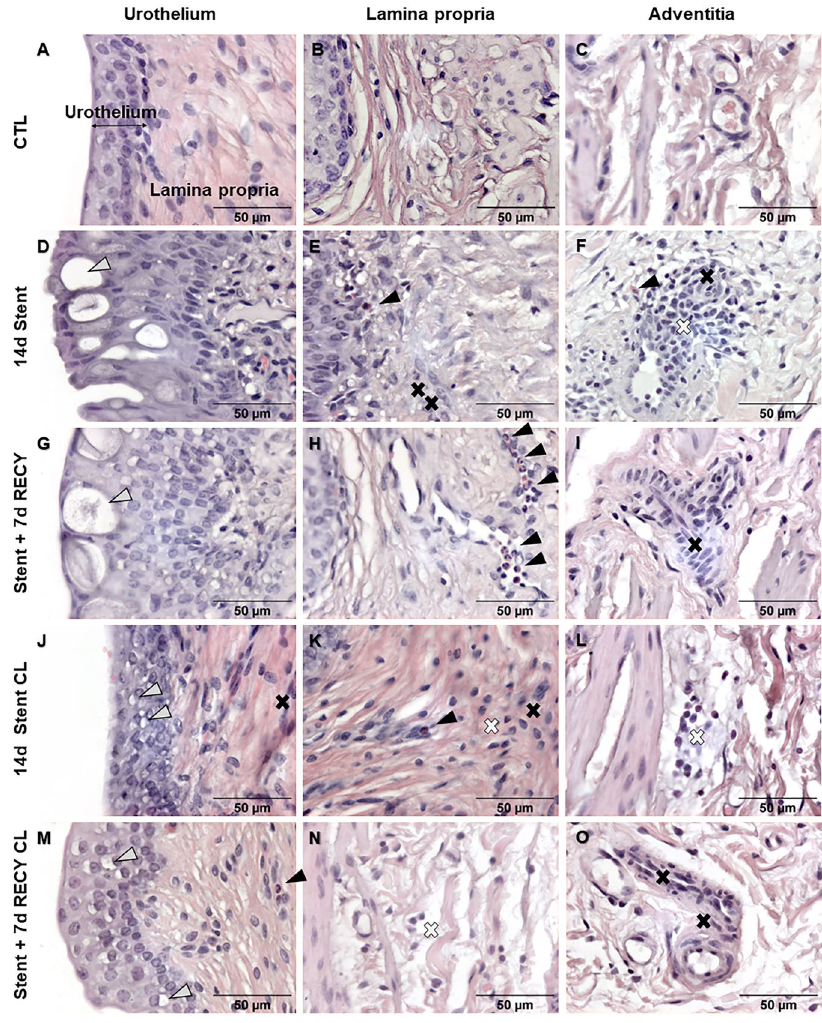
Figure 2. Qualitative evaluation of inflammation in stented ureters. ( A,B ) control ureter with urothelium consisting of 3–5 cell layers and an underlying lamina propria, ( C ) adventitia in a control ureter composed of loose connective tissue and normal vessel. ( D ) 14d stented ureter with thickened urothelium with 5–7 layers of cells and large vacuole (open arrowheads), ( E ) lamina propria with an increased leukocyte infiltration comprising eosinophils (arrowheads) and macrophages (black cross), ( F ) adventitia with hyperemic blood vessel transporting eosinophils (arrowheads). ( G ) 7 days after stent removal, urothelium persistently consisted of 5–7 cell layers and large vacuoles (open error head), ( H ) lamina propria with leucocyte infiltrate with eosinophils (arrowheads) and ( I ) adventitia with leukocyte infiltration and macrophages (black cross). ( J,M ) In contralateral, unstented ureters (14d Stent CL and Stent + 7d RECY), urothelium has 3–5 layers of cells with small vacuoles (open arrowheads), ( K,N ) the lamina propria is infiltrated by leucocytes comprising eosinophils (arrowhead), macrophages (black cross) and lymphocytes (white cross), and ( L,O ) the adventitia shows signs of hyperemia and macrophage infiltrates (black